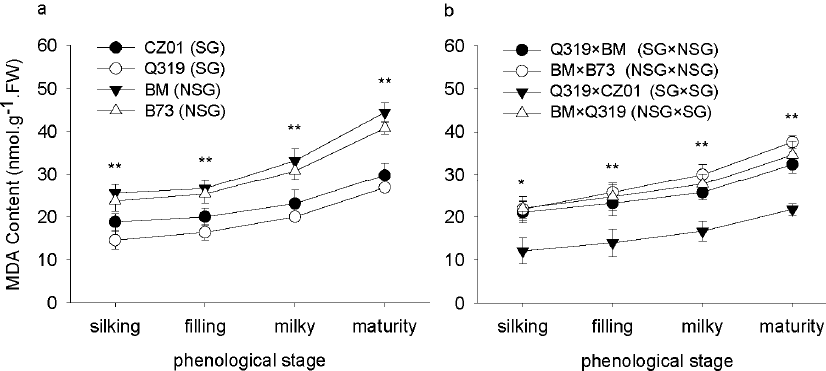
Figure 4. Malondialdehyde (MDA) content in ear leaves from different maize genetic backgrounds after silking. Values are means ± standard deviation ( n = 3). * indicates a significant difference between treatments at p < 0.05. ** indicates a significant difference between treatments at p < 0.01. ( a ) represents inbred lines, ( b ) represents hybrids. SG1 and SG2 are two types of maize for a higher stay-green ratio; CZ01, Q319, BM, B73 are the names of maize varieties.